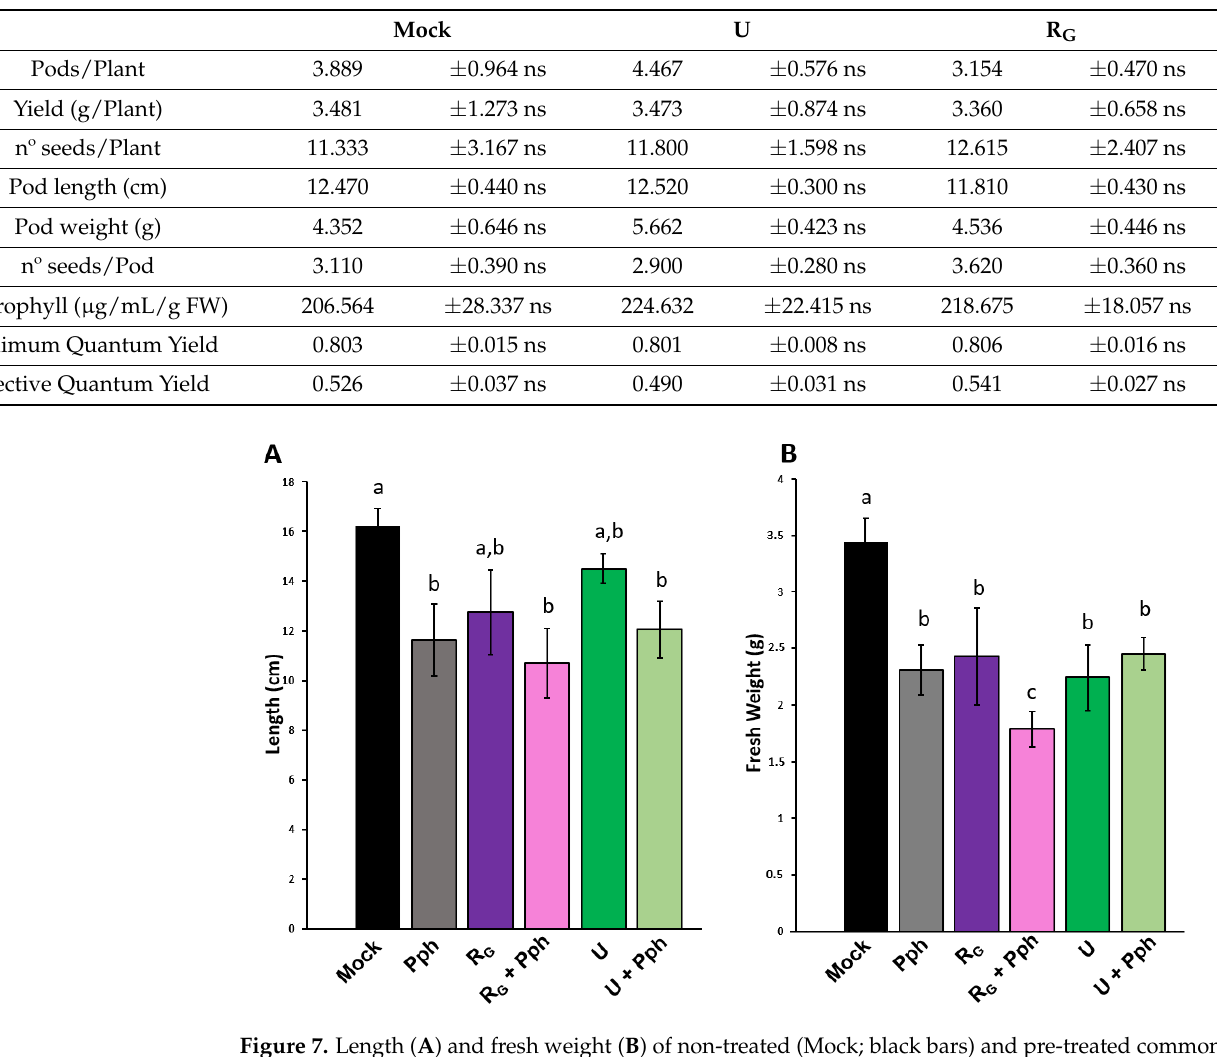
Figure 7. Length ( A ) and fresh weight ( B ) of non-treated (Mock; black bars) and pre-treated common bean with grapevine pomace (R G ; purple bars) and nettle (U; green bars), and their respective PBP- treated plants inoculated with Pph (R G + Pph; U + Pph; bars in corresponding soft colors). Data shown are the mean ± SE of three independent experiments. Statistically significant differences were achieved according to one-way ANOVA ( p < 0.05), post hoc Tukey test.